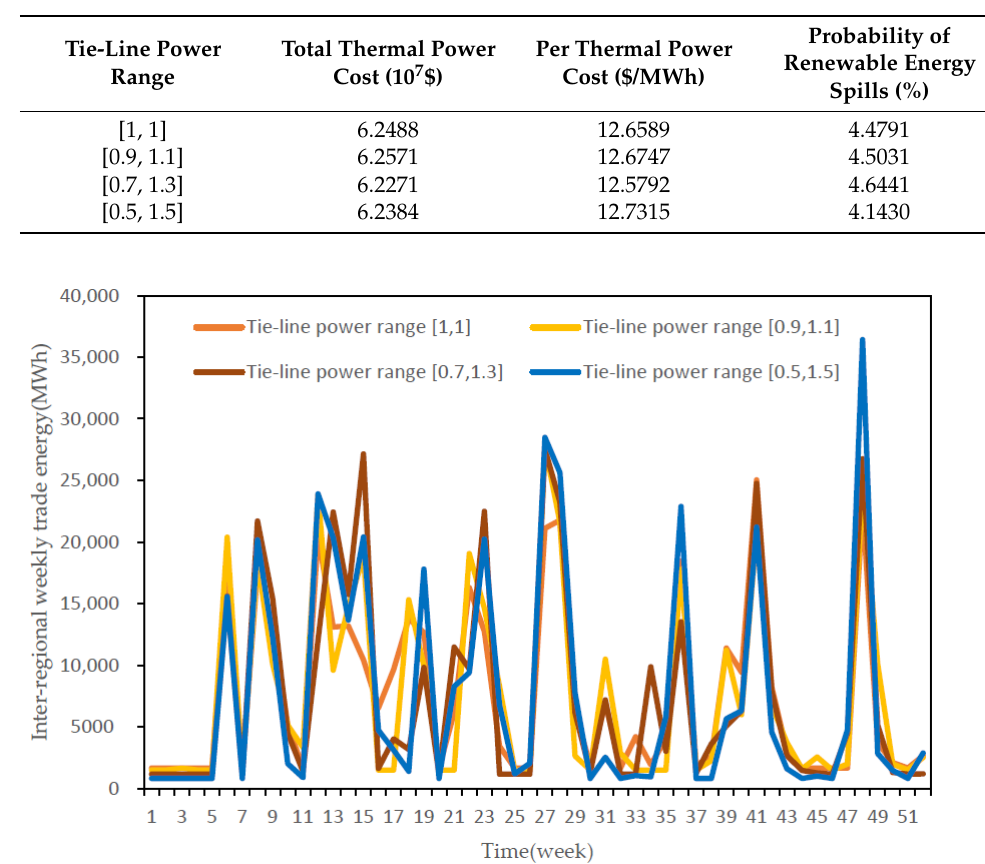
Figure 5. Cross-regional weekly trade energy.